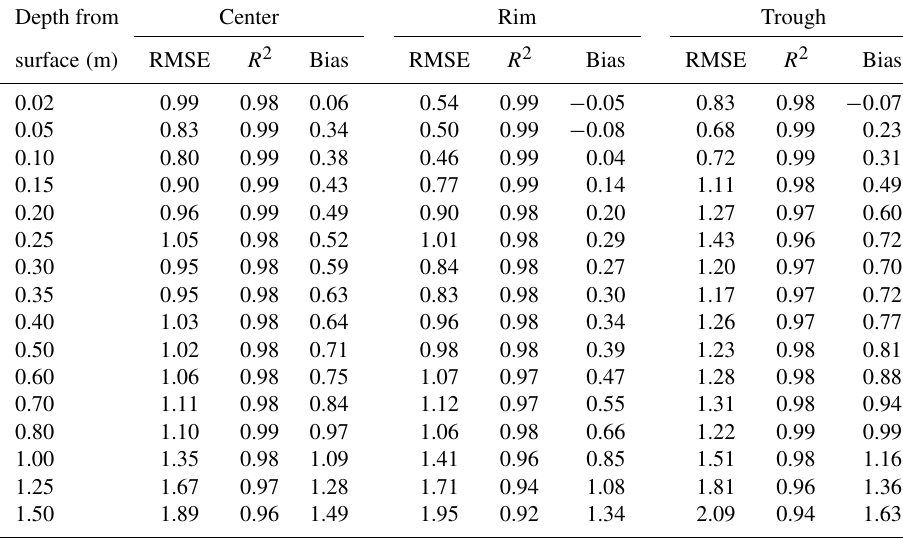
Table E2. Model performance statistics at Site B compared to observed soil temperatures. Depth from Center Rim Trough surface ( m ) RMSE R 2